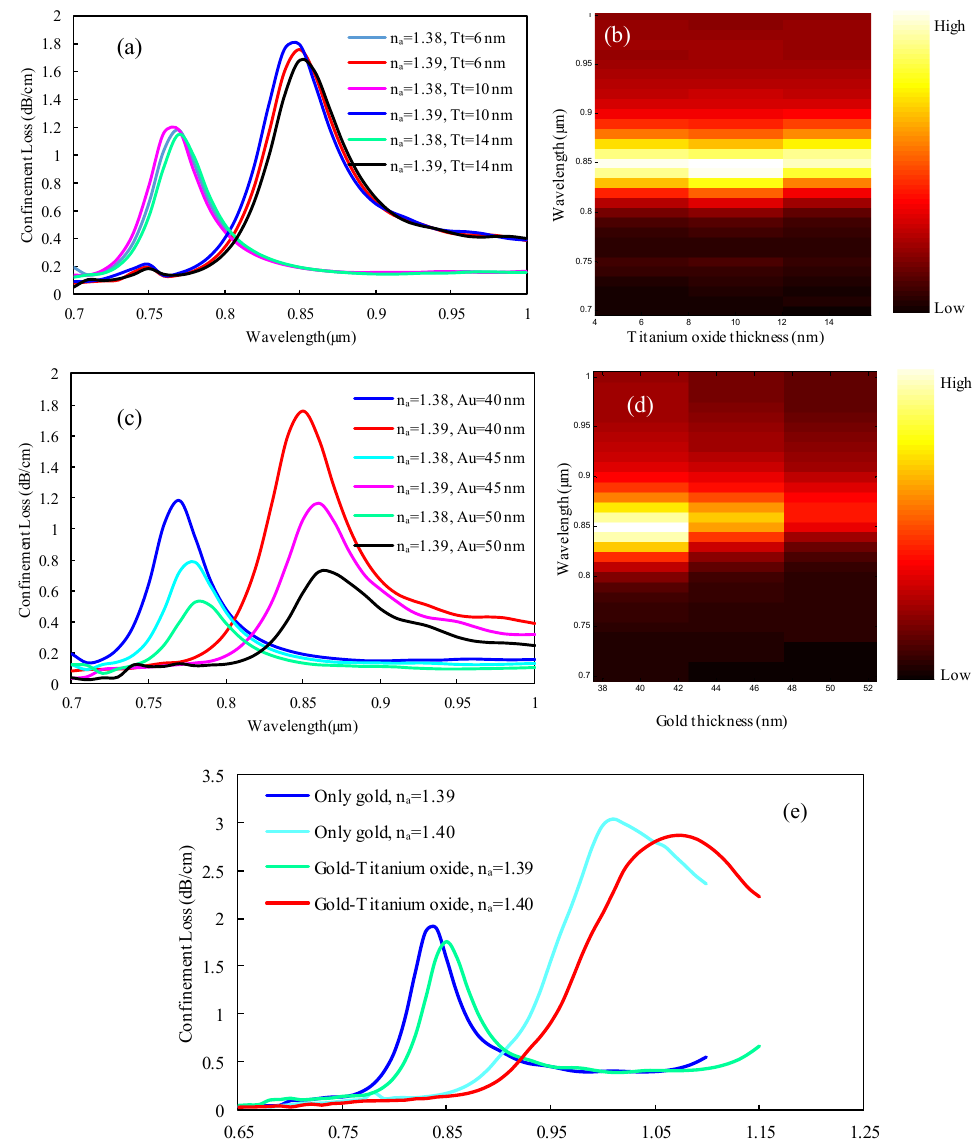
Figure 5. Observation of loss spectrum for ( a ) TiO 2 thickness variations and ( c ) Au layer thickness variations; ( b ) and ( d ) represent the normalized loss intensity for TiO 2 and Au thickness variations for n a of 1.39; ( e ) plasmonic material e ff ects of the Au-TiO 2 bimetallic layer and Au alone using optimized sensor parameters.